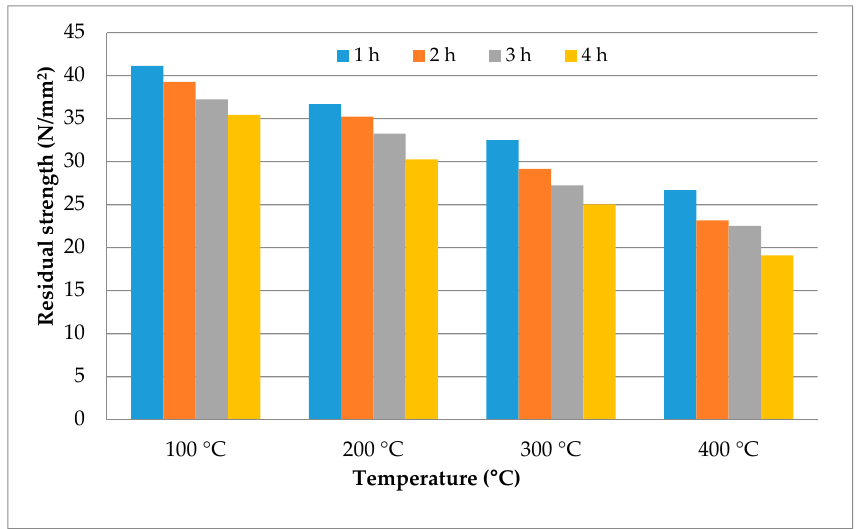
Buildings 2019 , 8 , x FOR PEER REVIEW Figure 10. Temperature versus residual strength of CCF mix. Figure 9. Temperature versus residual strength of CCF mix. Figure 9. Temperature versus residual strength of CCF mix.